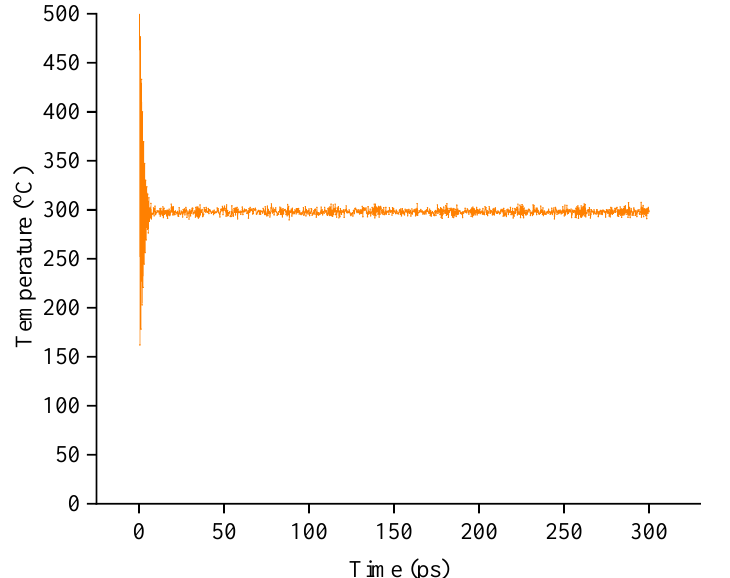
Figure 5. Variation in temperature during the NVT dynamics equilibration.